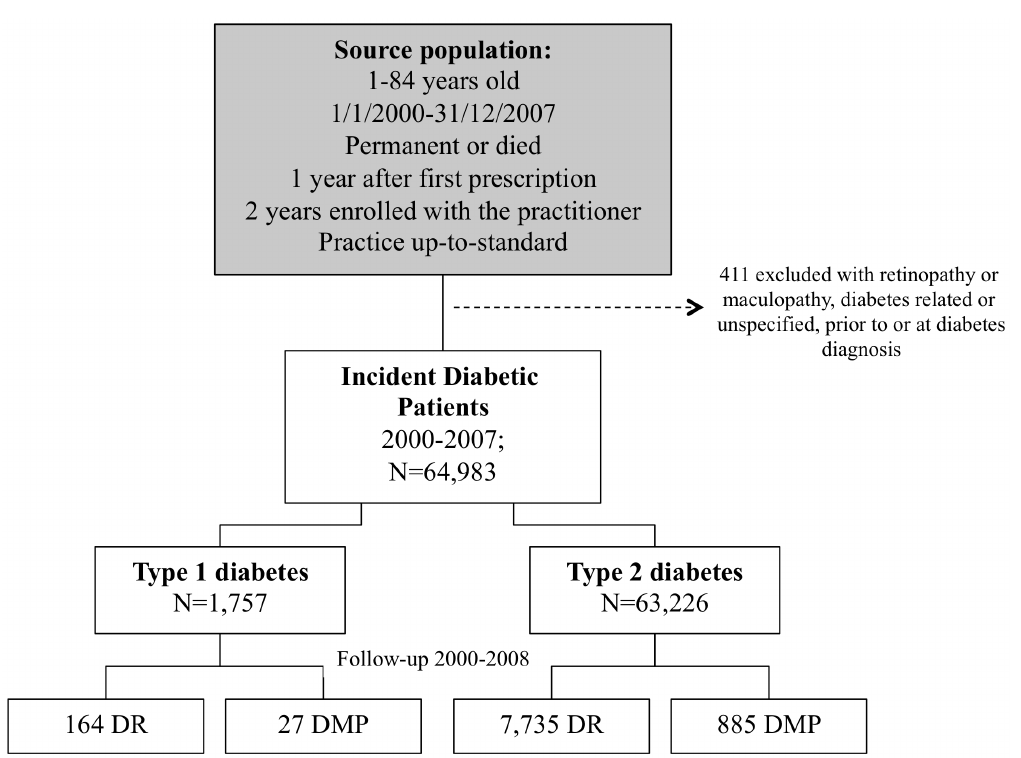
Figure 1. Flow of participants in cohort study of incidence of diabetic retinopathy (DR) and maculopathy (DMP) in patients with newly diagnosed type 1 and type 2 diabetes.